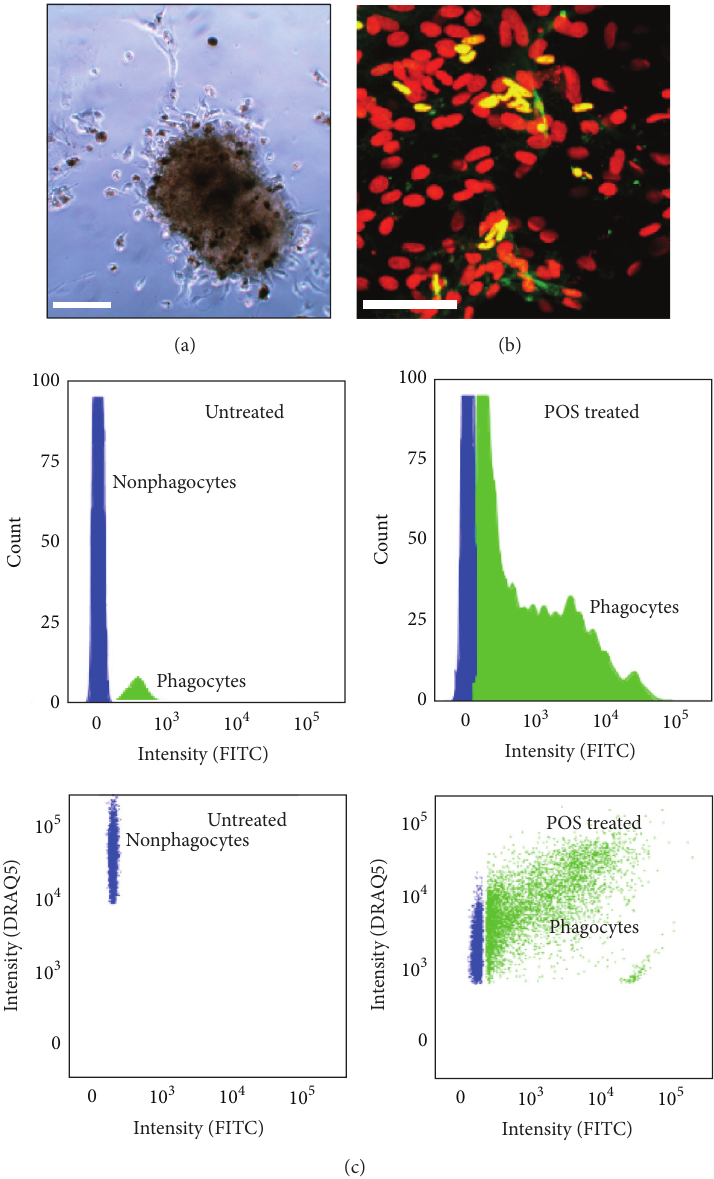
Figure 3: Data from immunocytochemistry and flow cytometry-based phagocytosis assays further suggest that the pigmented cells in the SRS are human RPE. (a and b) Pigmented clumps of cells from the subretinal space were isolated using RPE primary culture techniques (a). Some of the isolated cells are human RPE (labeled with antibodies that only recognize human OTX2—a molecular marker for RPE; DAPI = red; OTX2 = green (b)). (c) Some of the isolated cells internalized FITC-labeled porcine outer segments after five hours (labeled as phagocytes; green) in histograms (top panels) and scatter plots (bottom panels). DRAQ5 is a nuclear marker for living cells. Scale bars = 100 𝜇